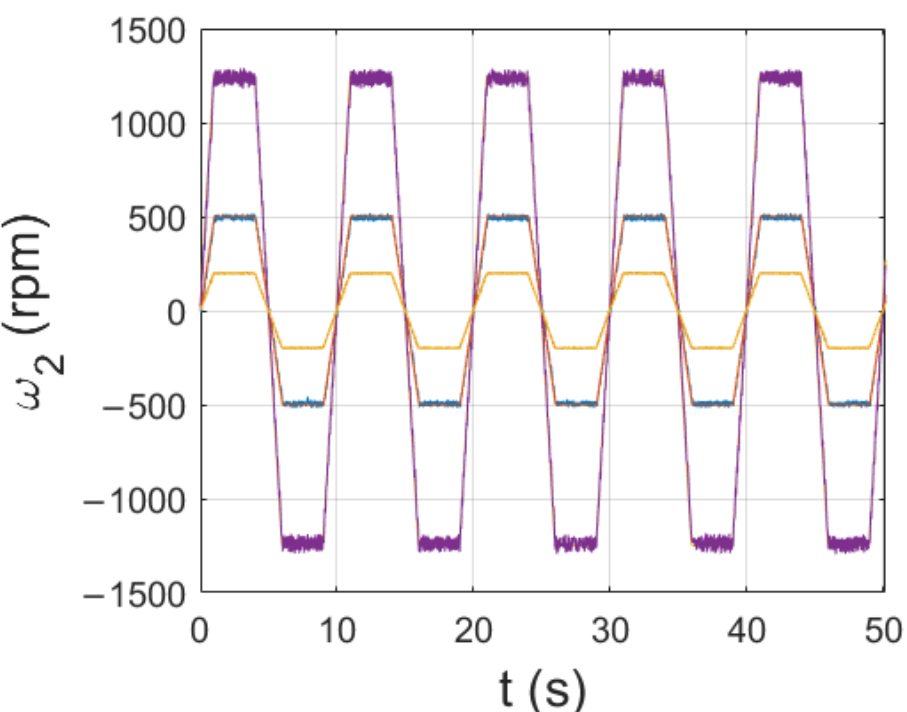
Figure 18. Load speed for different maximum values of the reference signal—experimental